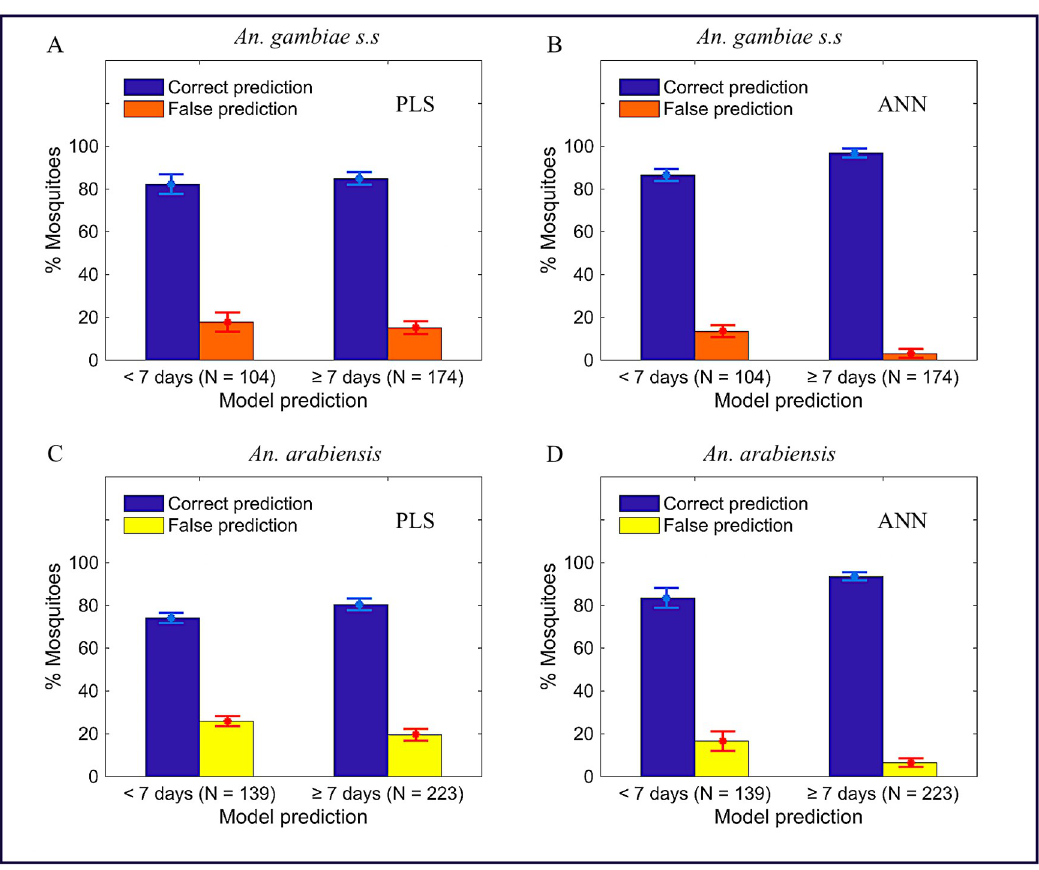
Fig 2. Number of An . gambiae s . s (A and B) and An . arabiensis (C and D) in two age classes (less than or greater/equal seven days) when PLS (A and C) and ANN (B and D) regression models, respectively, interpreted as binary classifiers.